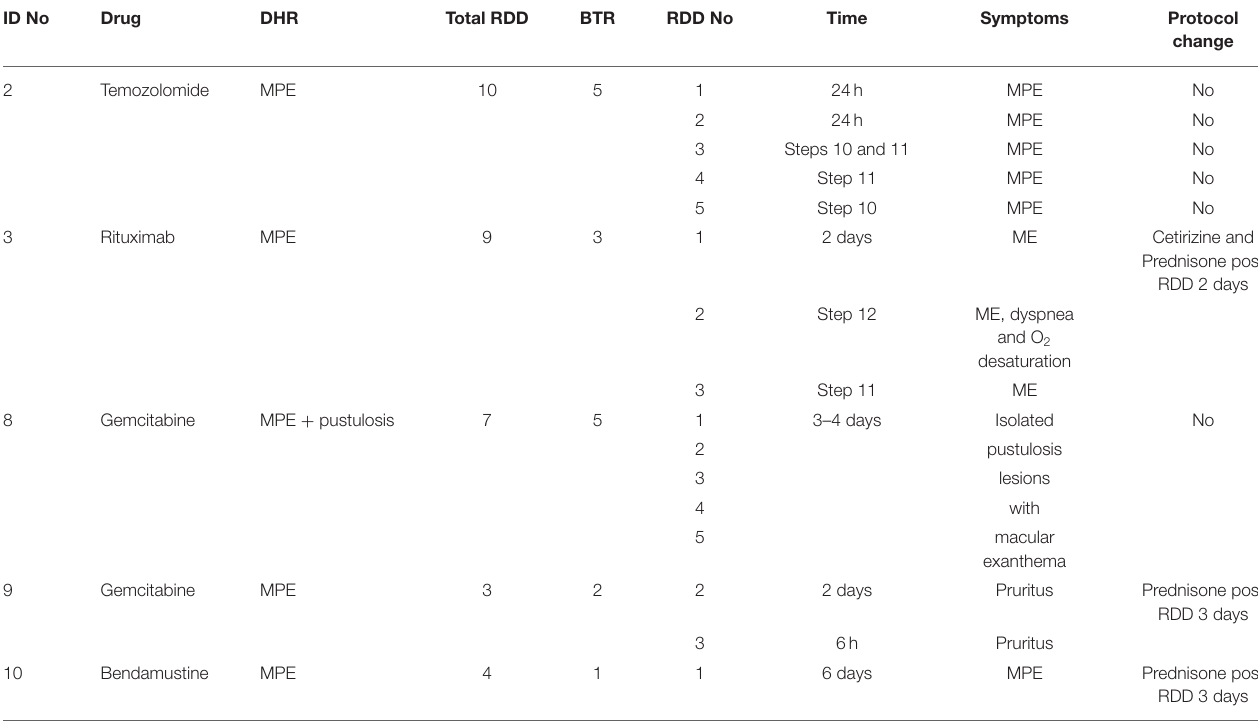
TABLE 3 | Characteristics of breakthrough reactions during